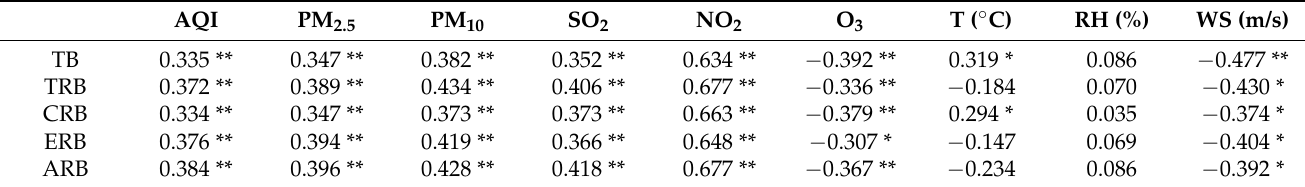
Table 2. Spearman correlation coefficients between culturable bacteria and the four antibiotic-resistant bacteria concentra- tions and main influencing